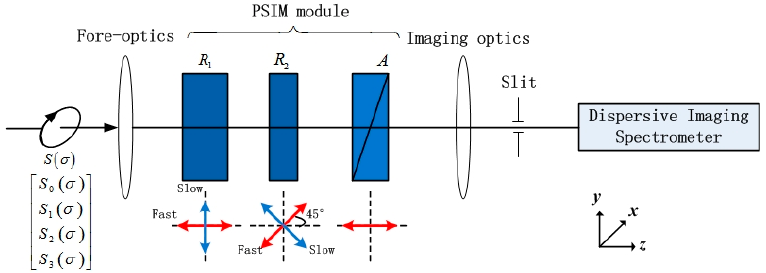
Figure 1. Optical schematic of the fieldable CDISP.